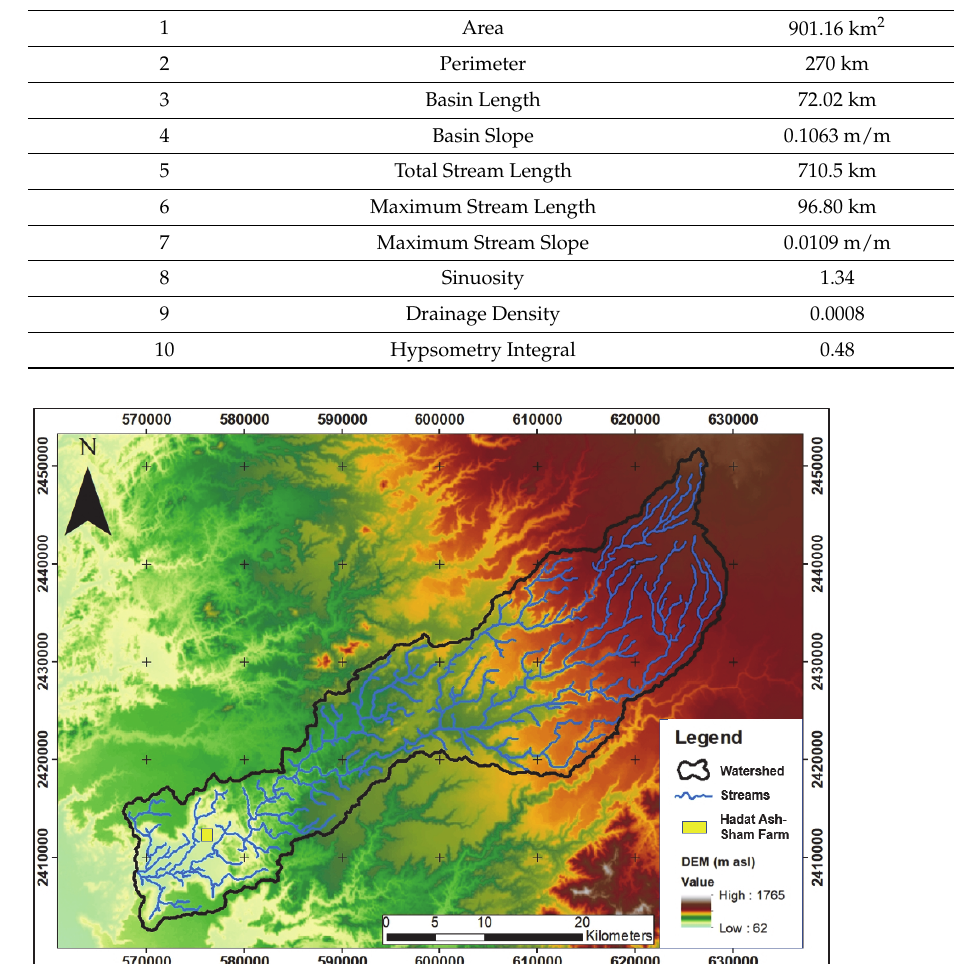
Figure 2. Al ‐ Lusub watershed drainage configuration according to digital elevation